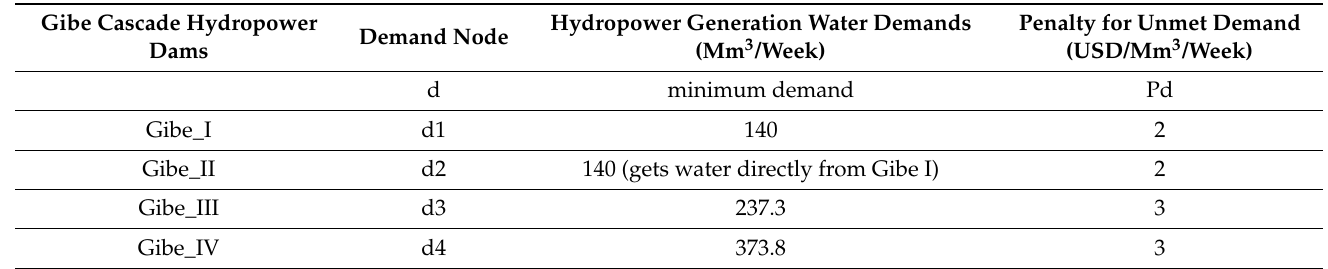
Table 9. Gibe cascade hydropower demands